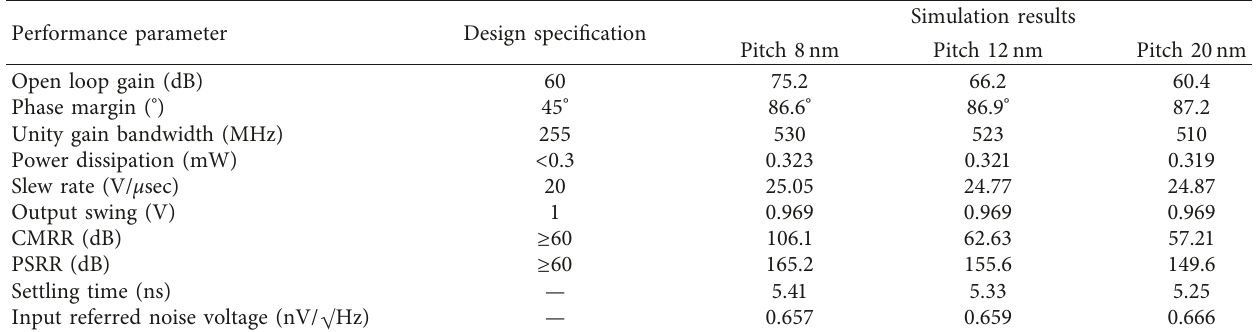
Table 2: Comparative results at different values of pitch.